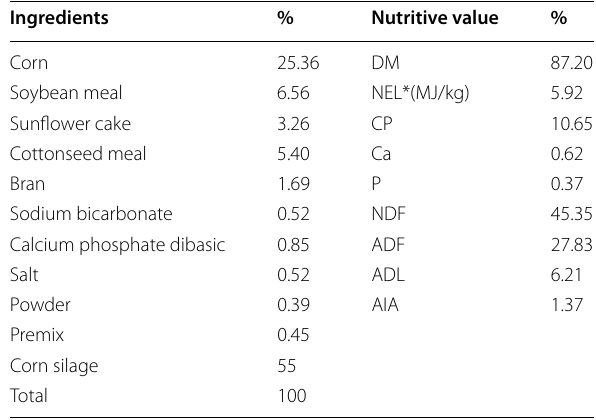
Table 5 Ingredients and nutritive value of experimental